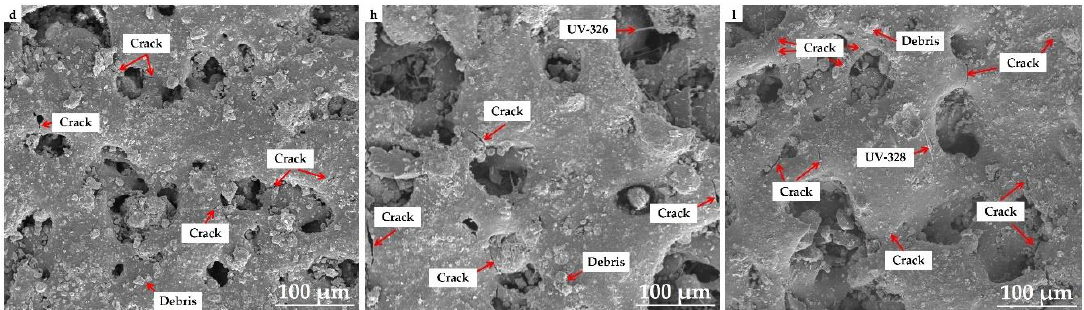
Figure 5. Micromorphologies of samples before and after accelerated aging: ( a–d ) P/L with accelerated aging for 0, 10, 20, and 30 d; ( e – h ) P/L-6 with accelerated aging for 0, 10, 20, and 30 d; and ( i – l ) P/L-8 with accelerated aging for 0, 10, 20, and 30 d.